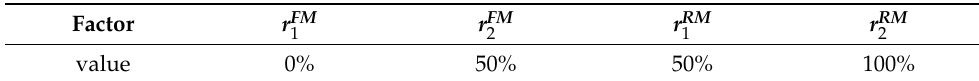
Table 2. Rear and front torque contribution